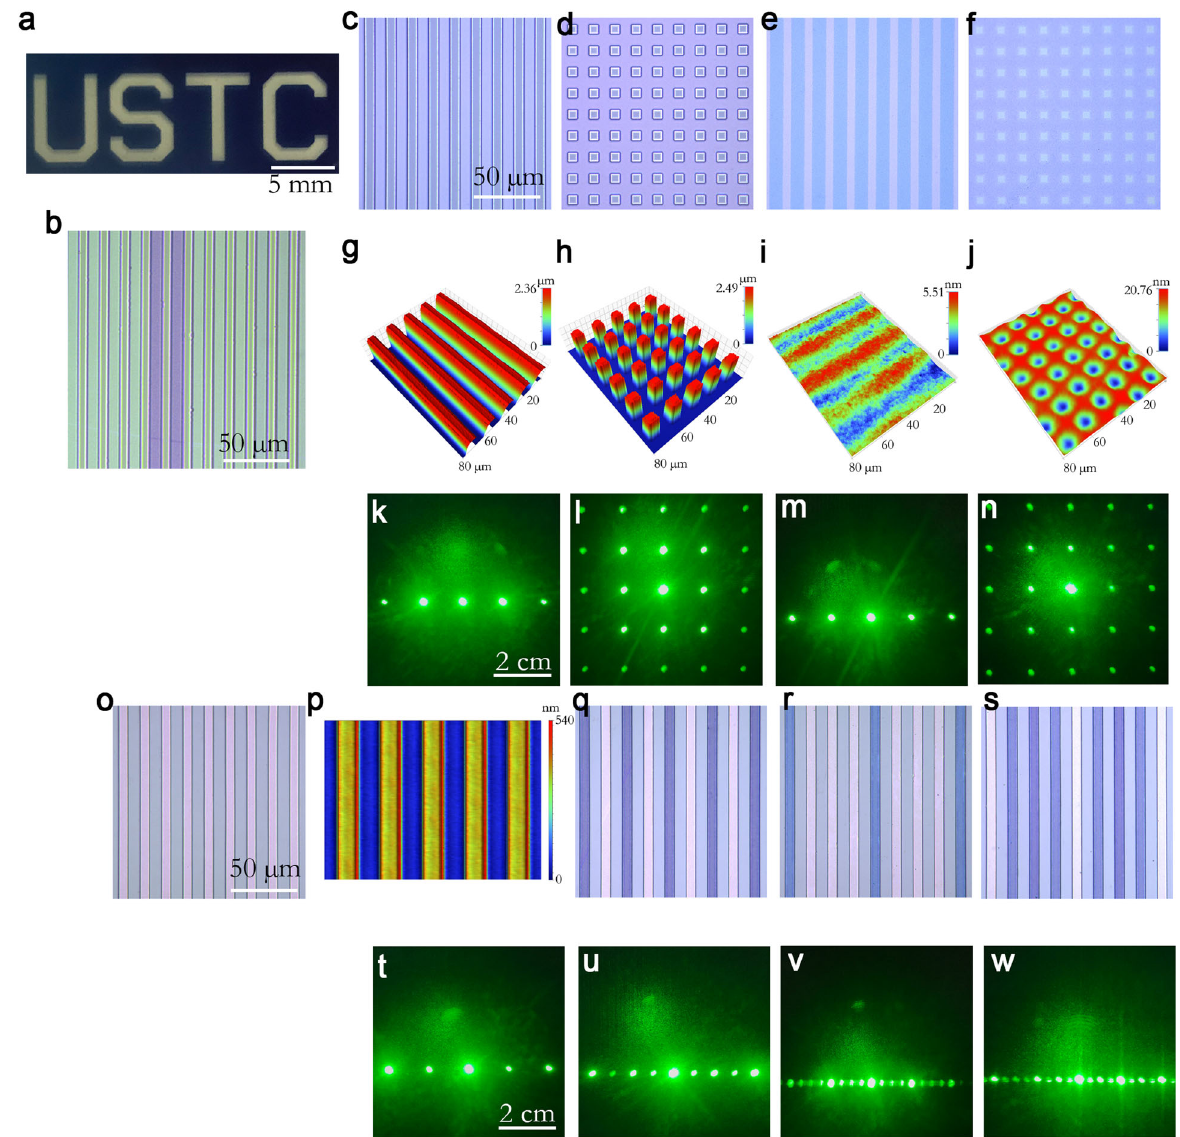
Fig. 3 The performance of rewritiable WO 3 -based gratings. a Photoresist is covered on a WO 3 fi lm as the shape of “ USTC ” , which proves that photoresist would hinder the electron – proton synergistic doping. b The synergistic effect is compatible with UV lithography, which can be conducted in microchannels by coating photoresist. c-f The photos recorded by optical microscope: a photoresist array in bar shape ( c ) and a photoresist array in square shape ( d ). After being processed by synergistic doping and lift-off, the corresponding pattern of bars ( e ) and squares ( f ) were obtained. Panels c – f have the same scale bar. The period is 16 μ m. g – j The corresponding surface morphology of samples in panels c – f . k – n The corresponding diffraction spots of samples in panels c – f . For panels k – n , scale bar is the same. o The WO 3 relief grating in the period of 16 μ m, p surface morphology, t diffraction spots. q – s Adjusting the period of the relief grating by the synergistic doping, 32 μ m for panel q , 64 μ m for panel r , 64 μ m for panel s . u – w The corresponding diffraction spots of samples in panels q – s . For panels o and q – s , scale bar is the same. For panels t – w , scale bar is the